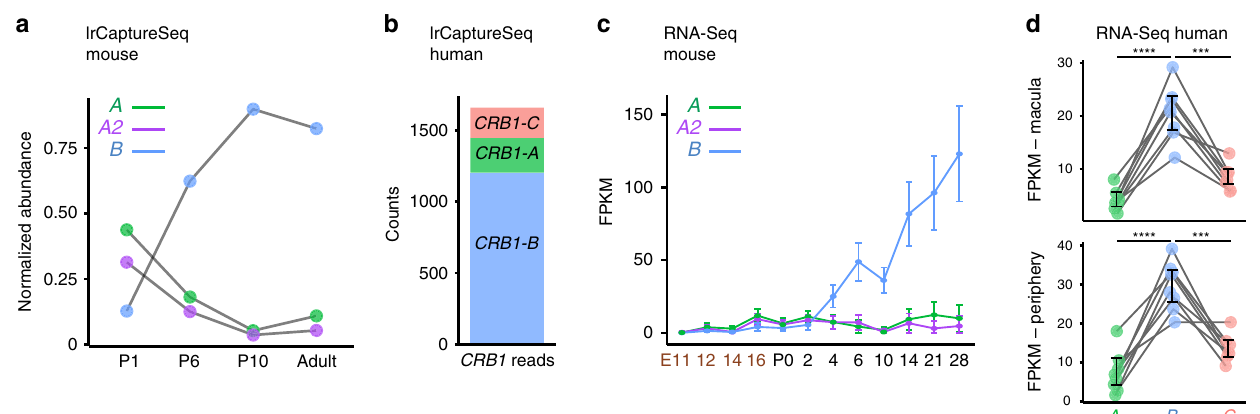
Fig. 6 Crb1-B is the most abundant Crb1 isoform in mouse and human retina. a Retinal expression of top 3 Crb1 isoforms across mouse development, quanti fi ed from lrCaptureSeq dataset. A isoforms predominate at P1 but Crb1-B becomes most abundant by P6. Data were normalized to total Crb1 read counts at each timepoint (P1 = 923 reads, P6 = 6127 reads, P10 = 14,007 reads, Adult = 10,975 reads). b Expression of top 3 human CRB1 isoforms, quanti fi ed from adult human retina lrCaptureSeq dataset. c , d Short-read RNA-seq data was used to quantify top 3 mouse ( c ) or human ( d ) CRB1 isoforms. Mouse dataset (GSE101986; n = 2 biological replicates per time point) con fi rms developmental regulation of each isoform observed in PacBio data ( a , c ). Human dataset (GSE94437; n = 8 biological replicates) con fi rms CRB1-B is dominant isoform in adult macula ( d , top) and peripheral retina ( d , bottom).